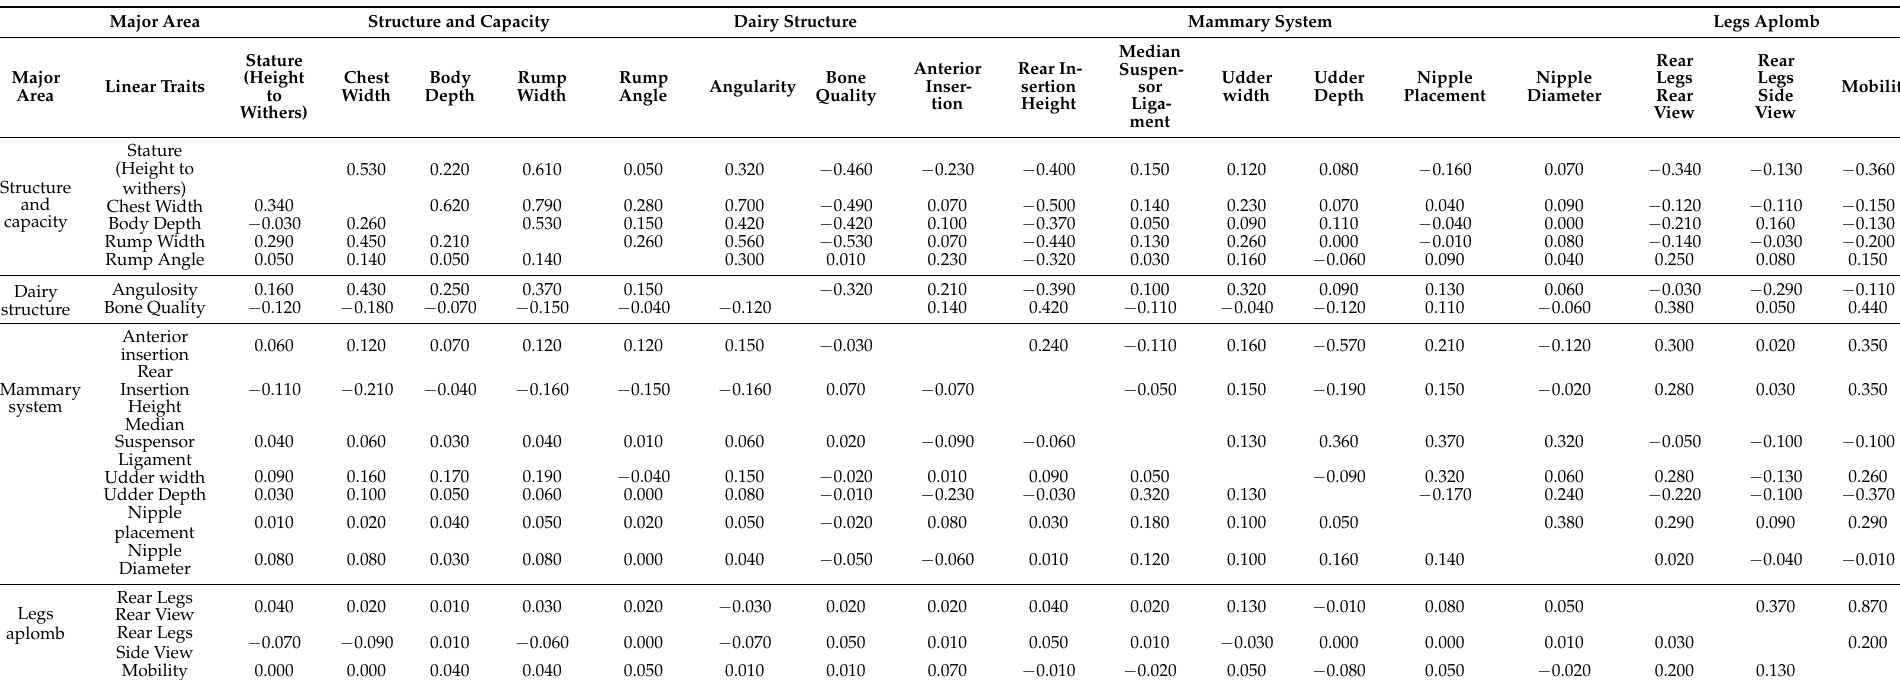
Table 5. Estimated genetic (r G ) (above diagonal) and phenotypic (r P ) (below diagonal) correlations for zoometric and LAS traits obtained in bivariate analyses through